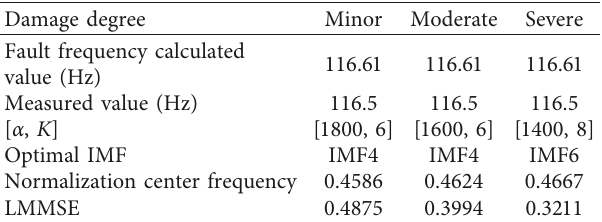
Figure 11: Vibration signals under different pitting radius. Table 3: Experimental data under different fault